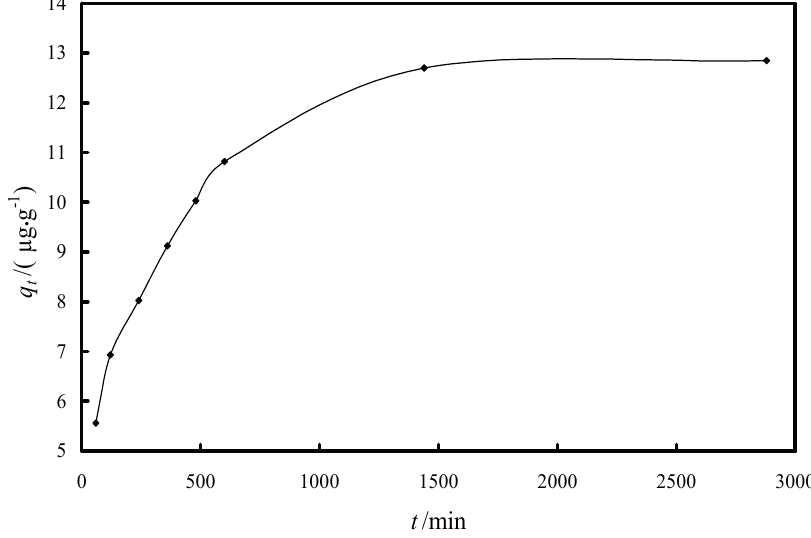
Figure 4. Effect of contact time on the As(V) adsorption capacity of